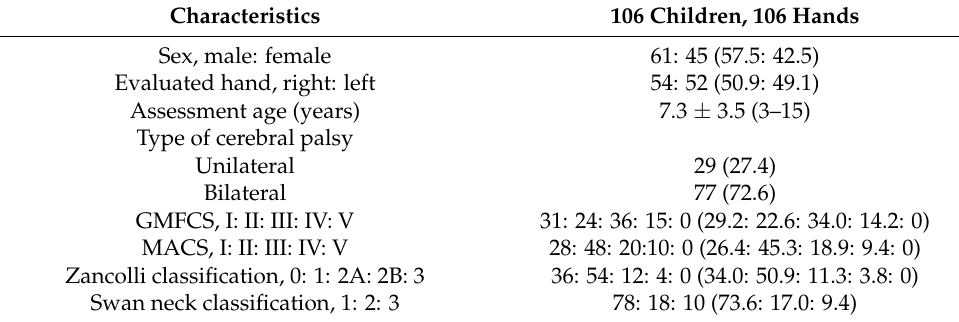
Table 1. Baseline